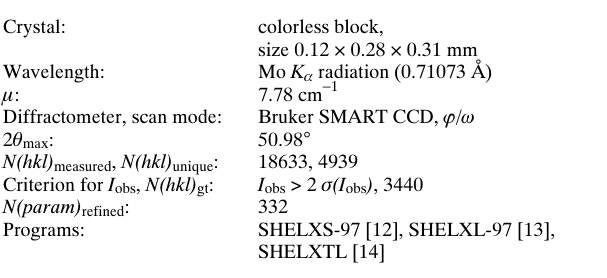
Table 1. Data collection and handling.